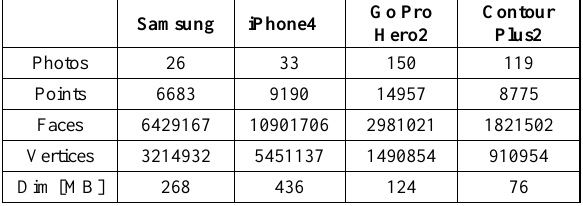
Table 3 - Mesh and point clouds